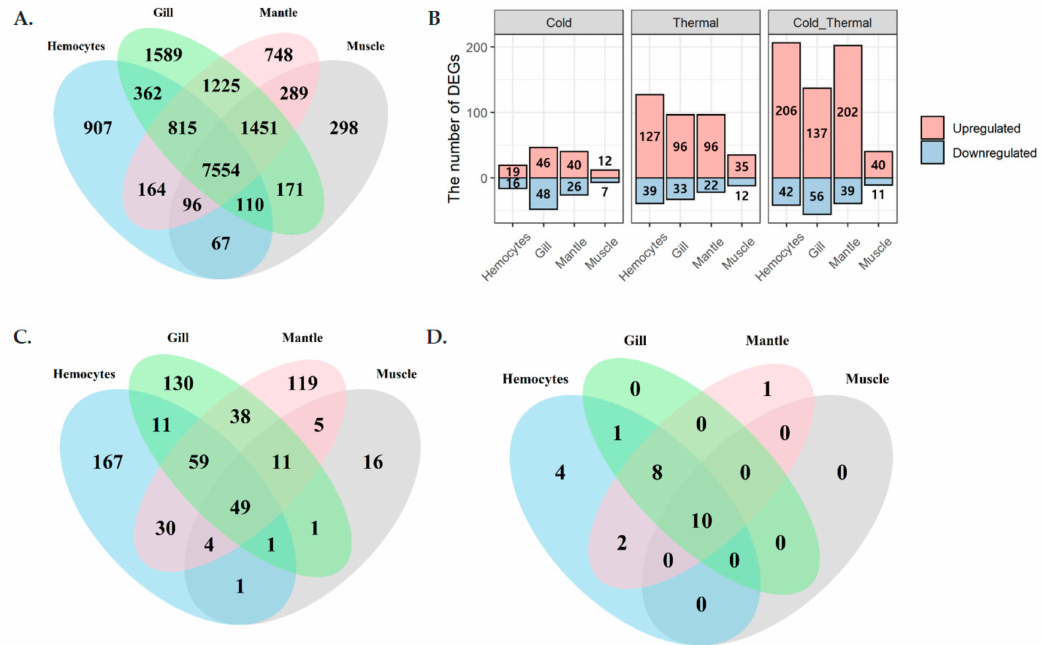
Figure 2. Tissue-specific expression and di ff erential expression profiles among cold and thermal-stress conditions, observed by total RNA sequencing (RNA-Seq) analysis. ( A ) Tissue-specific expression, ( B ) di ff erentially expressed genes among cold- and thermal-temperature conditions while compared with optimal temperature, ( C ) di ff erentially expressed genes in di ff erent tissues, and ( D ) di ff erentially expressed